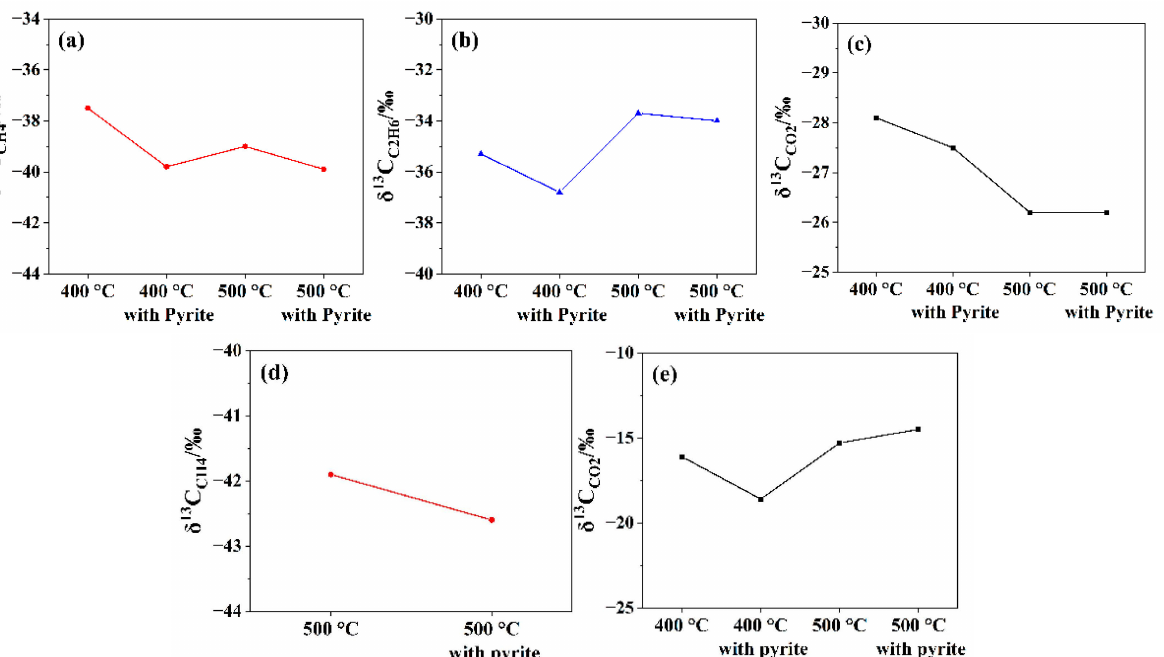
Figure 6. Measured δ 13 C values of ( a ) CH 4 , ( b ) C 2 H 6 and ( c ) CO 2 for the Geniai shale and ( d ) CH 4 and ( e ) CO 2 for the Wenjiaba